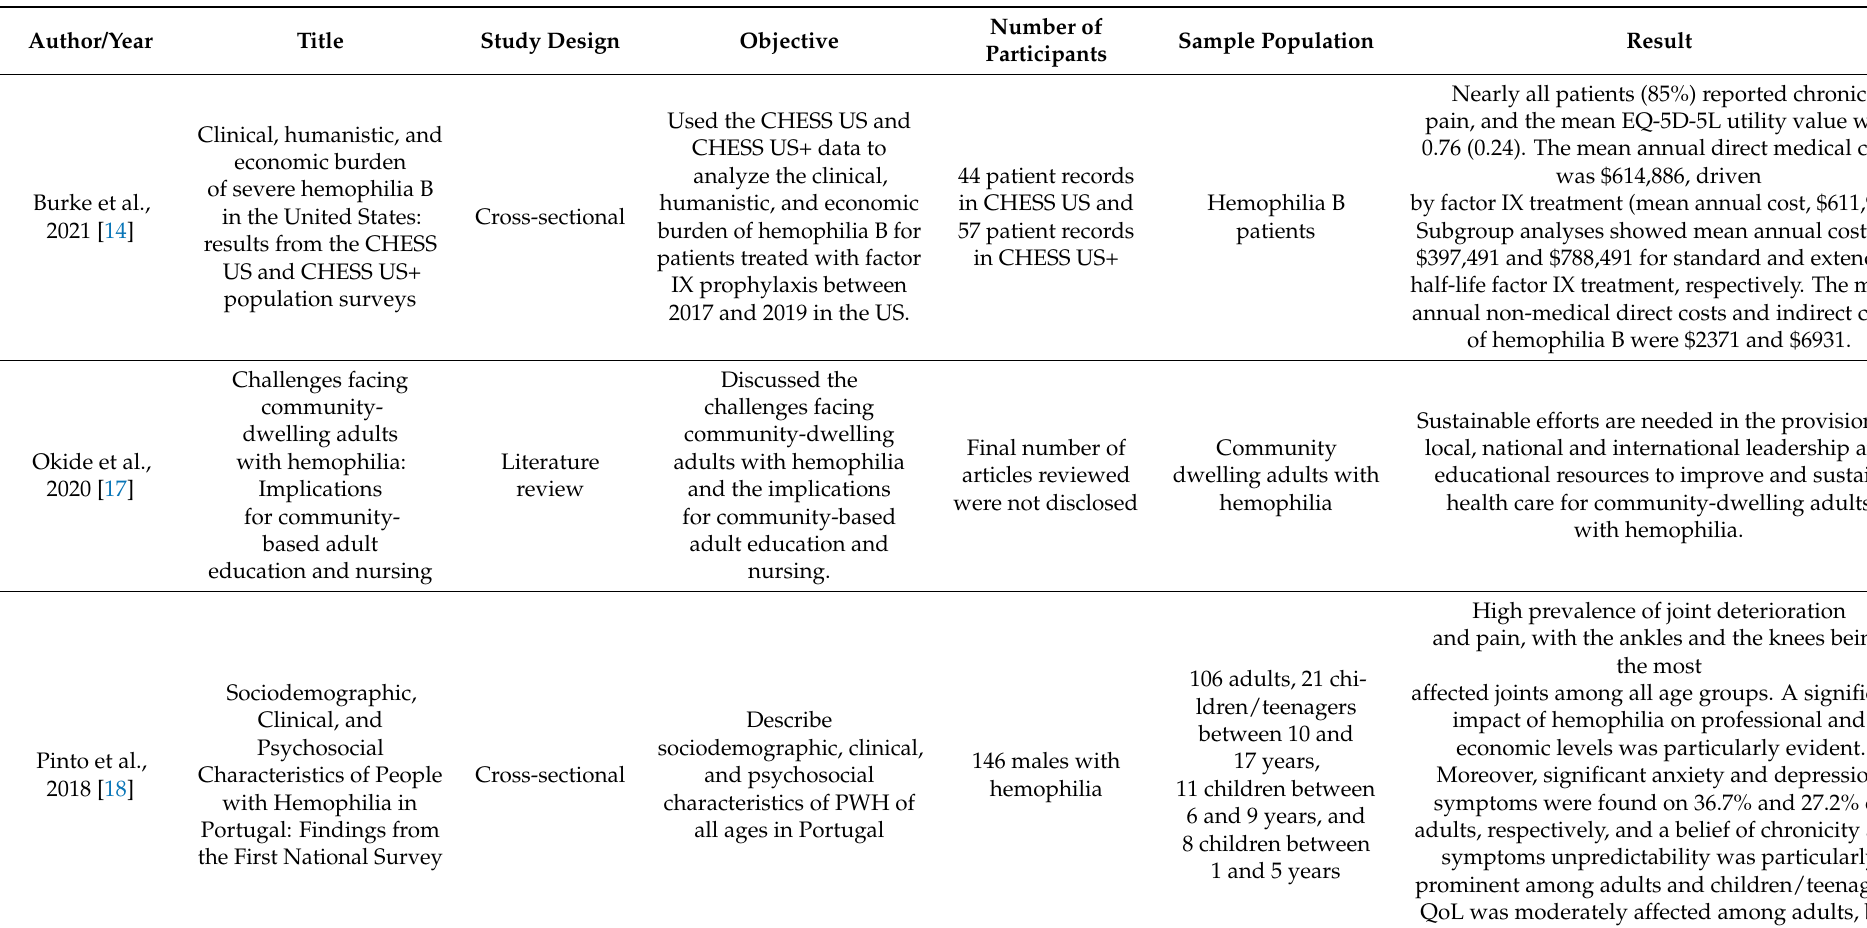
Table 2. Summary of articles found focused on Economic